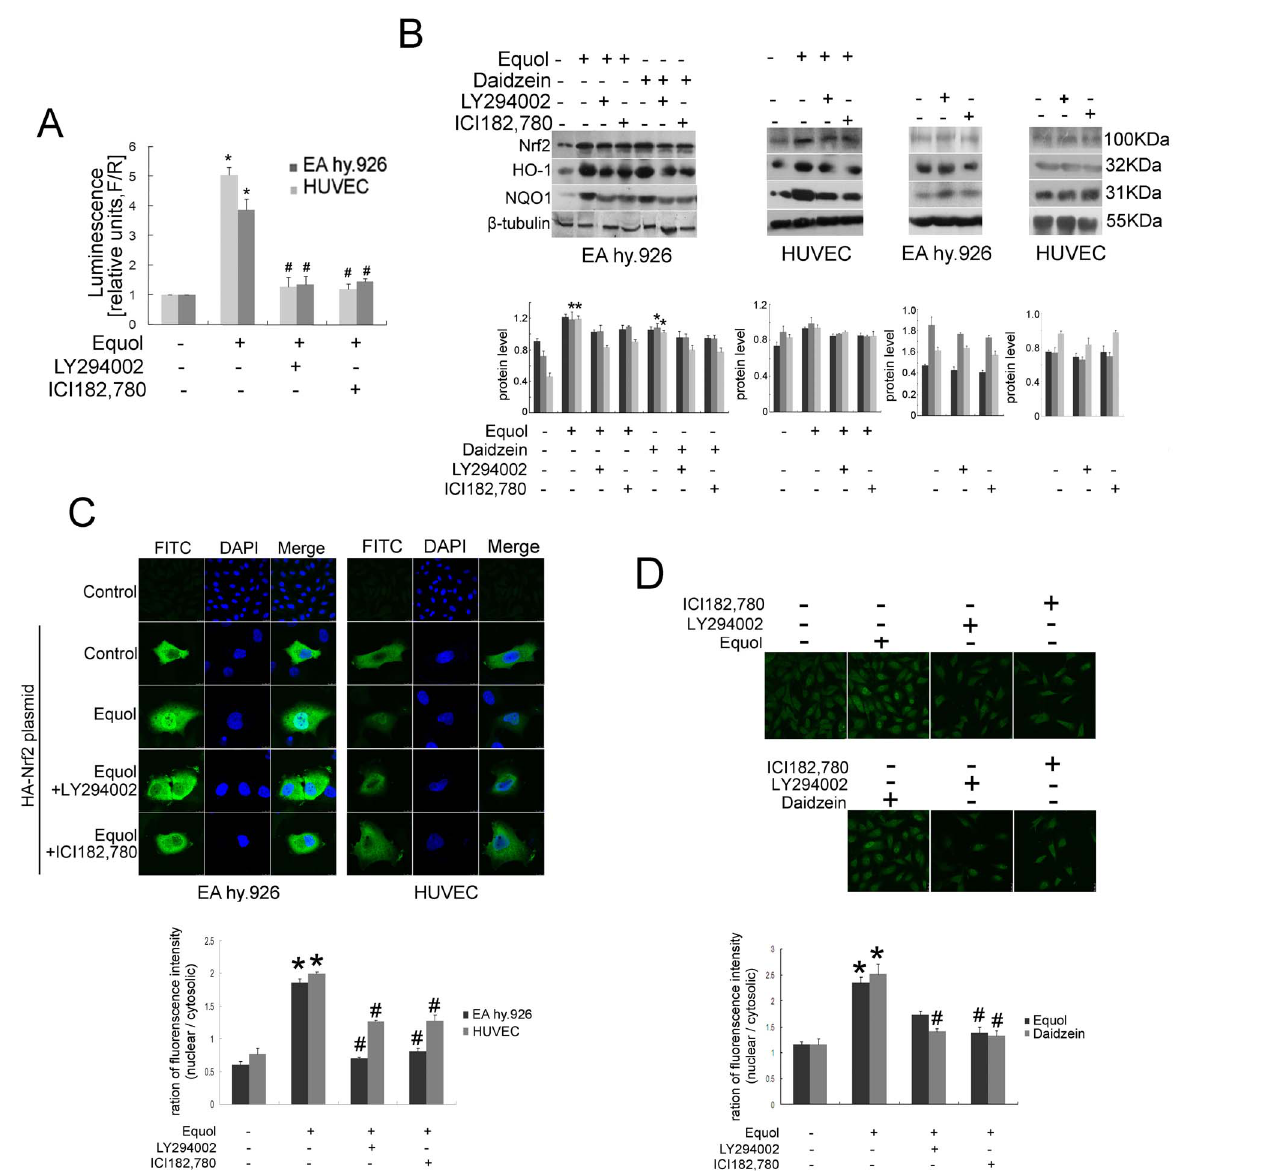
Figure 3. The effects of PI3K/Akt and ER inhibitors on S- (-)equol-induced Nrf2 activation in endothelial cells. (A) EA.hy926 cells or HUVECs were transfected with ARE-dependent firefly luciferase reporter gene ( F ) and the renilla firefly luciferase gene ( R ), and treated with 250 nM S- (-)equol in the presence or absence of 10 m M LY294002 or 100 nM ICI182,780 for 16 h. The potency of induction is expressed as the relative luminescence (R/F) measured using the dual luciferase reporter assay system (mean 6 SD, n=3). * p , 0.05 versus with control group, # p , 0.05 versus with S- (-)equol treated group. (B) EA.hy926 cells or HUVECs were incubated with or without 10 m M LY294002 or 100 nM ICI182,780 for 30 min and then with or without 250 nM S- (-)equol or 500 nM daidzein for 24 h. Whole cell lysates were then immunoblotted with antibodies against Nrf2, HO-1, NQO1, and b -tubulin. Values are means of three independent experiments with standard deviations represented by vertical bars. Mean values were significantly different compared with controls (* p , 0.05). (C) EA.hy926 cells or HUVECs cotransfected with the HA-Nrf2 and renilla firefly luciferase expression plasmids were treated with 250 nM S- (-)equol in the presence or absence of 10 m M LY294002 or 100 nM ICI182,780 for 16 h, and HA-Nrf2 localization was analyzed by confocal microscopy. (D) EA.hy926 cells were incubated with 250 nM S- (-)equol, 500 nM daidzein with or without 10 m M LY294002 or 100 nM ICI182,780 for 16 h and then immunostained with an antibody against Nrf2, and Nrf2 localization was analyzed by confocal microscopy. Values (intensity of nuclear versus cytoplasmic) are means of counting 100 cells with standard deviations represented by vertical bars. * p , 0.05 versus with control group, # p , 0.05 versus with S- (-)equol treated group. doi:10.1371/journal.pone.0079075.g003 As shown in Figure 4B1 and 2, both ER a and ER b were were treated with the specific ER b activator (Figure 4B4), DPN or the specific ER a activator, PPT (Figure 4B3). expressed in HUVECs, with weaker expression of ER a (Figure 4B1) than ER b (Figure 4B2). S- (-)equol treatment Immunofluorescence revealed the same trend in expression with remarkably upregulated ER b (Figure 4B6) but not ER a regard to Nrf2 activation (Figure 4C). DPN (10 nM) treatment (Figure 4B5) expression compared with positive control which notably induced Nrf2 nuclear translocation, whereas PPT (10 nM)